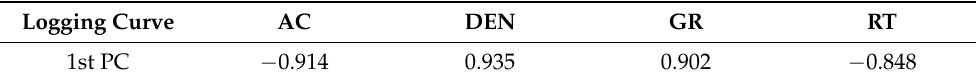
Table 4. Component matrix and component score coefficients. Logging